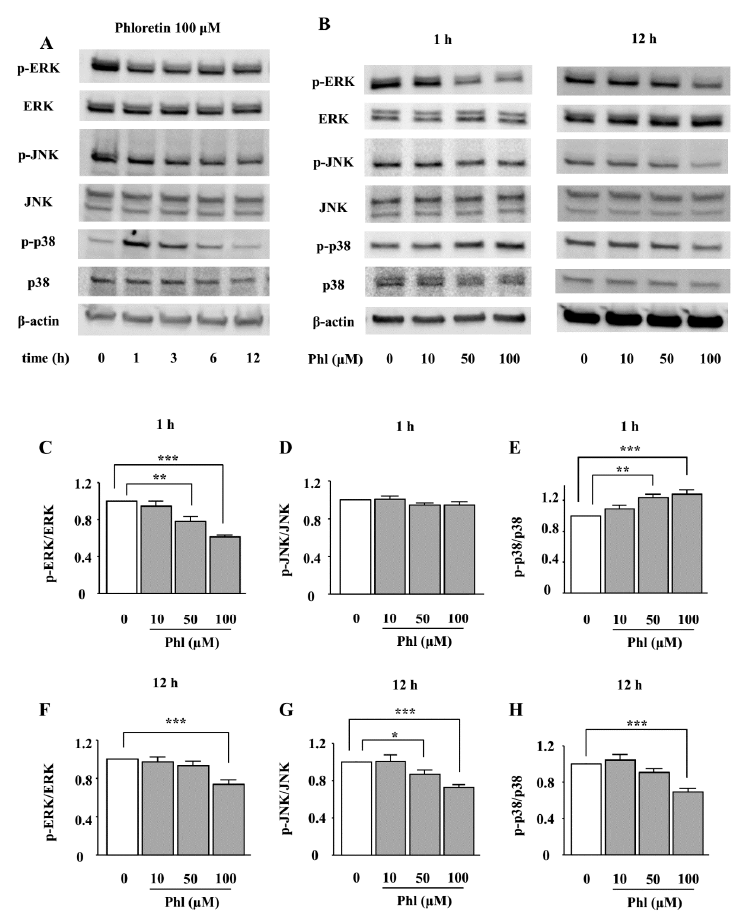
Figure 3. The effects of phloretin on the phosphorylation of MAPKs in ST2 cells. ( A – H ) After reaching confluency, ST2 cells were incubated in adipogenic medium for 48 h. Thereafter, the cells were treated with 100 µM phloretin for up to 12 h, and western blot analysis was performed to examine the time-dependent effects of phloretin on the phosphorylation of ERK1/2, JNK, and p38 MAPK ( A ). To test dose dependency, the cells were treated with phloretin (0 to 100 µM) for 1 and 12 h ( B ). The results are representative of at least five experiments. ( C – H ) The quantification results are expressed as mean ± SE ( n ≥ 5); * p < 0.05, ** p < 0.01, *** p < 0.001. Phl: phloretin.